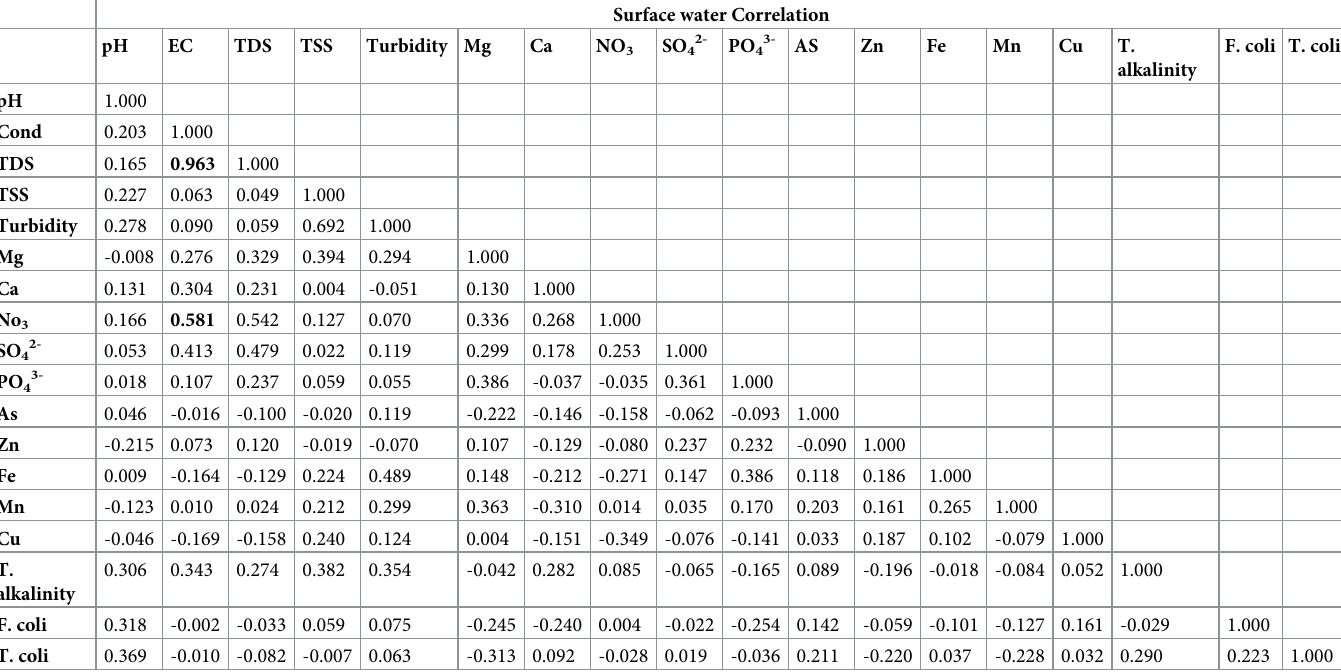
Table 3. Pearson’s correlation matrix for analyzed water quality parameters in surface water.